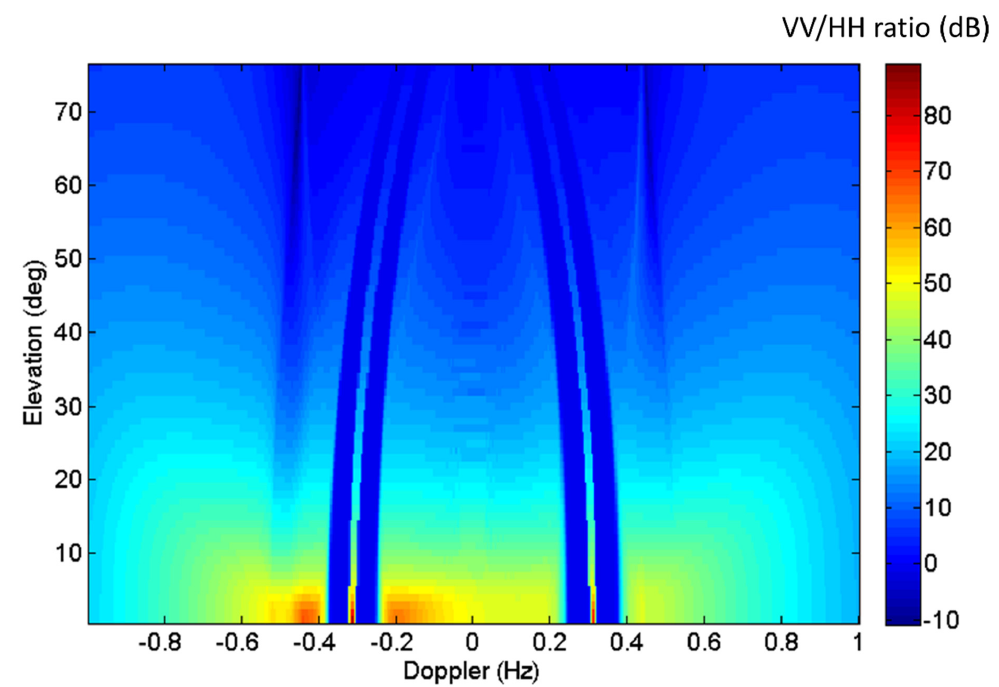
Figure 12. The ratio of the VV power spectral density to that for HH polarisation, for representative sea conditions. The dark blue bands around the Bragg frequency are set to zero because both VV and HH polarisations have nulls there.